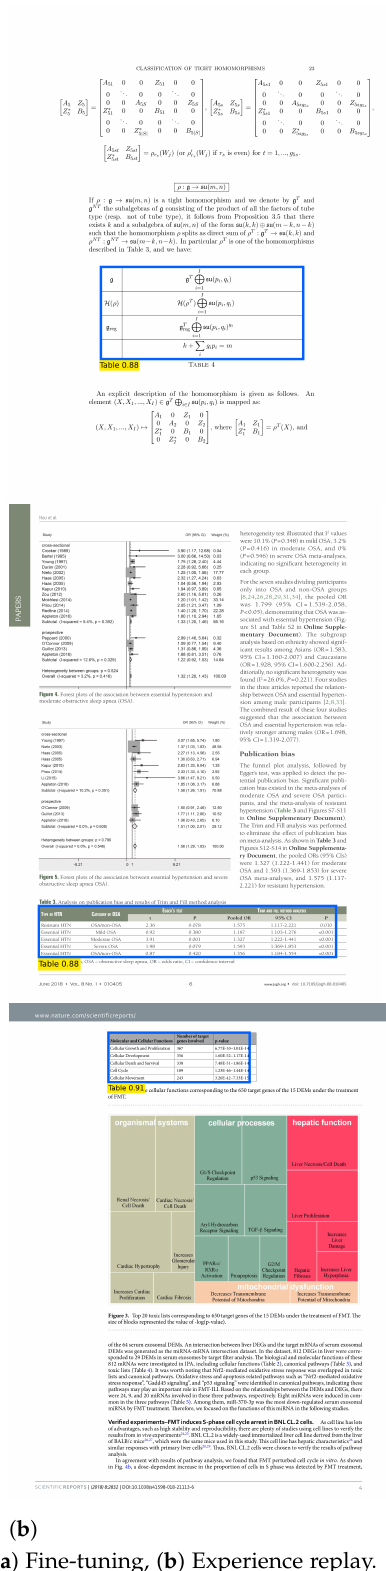
Figure 6. The qualitative results using two methods: ( a ) Fine-tuning, ( b ) Experience replay. Blue represents true positive, and red denotes false positive. The samples are from TableBank, PubLayNet, and PubTables-1M datasets, respectively. The Experience replay method maintains the performance but the fine-tuning approach suffers from false detection and inaccurate bounding